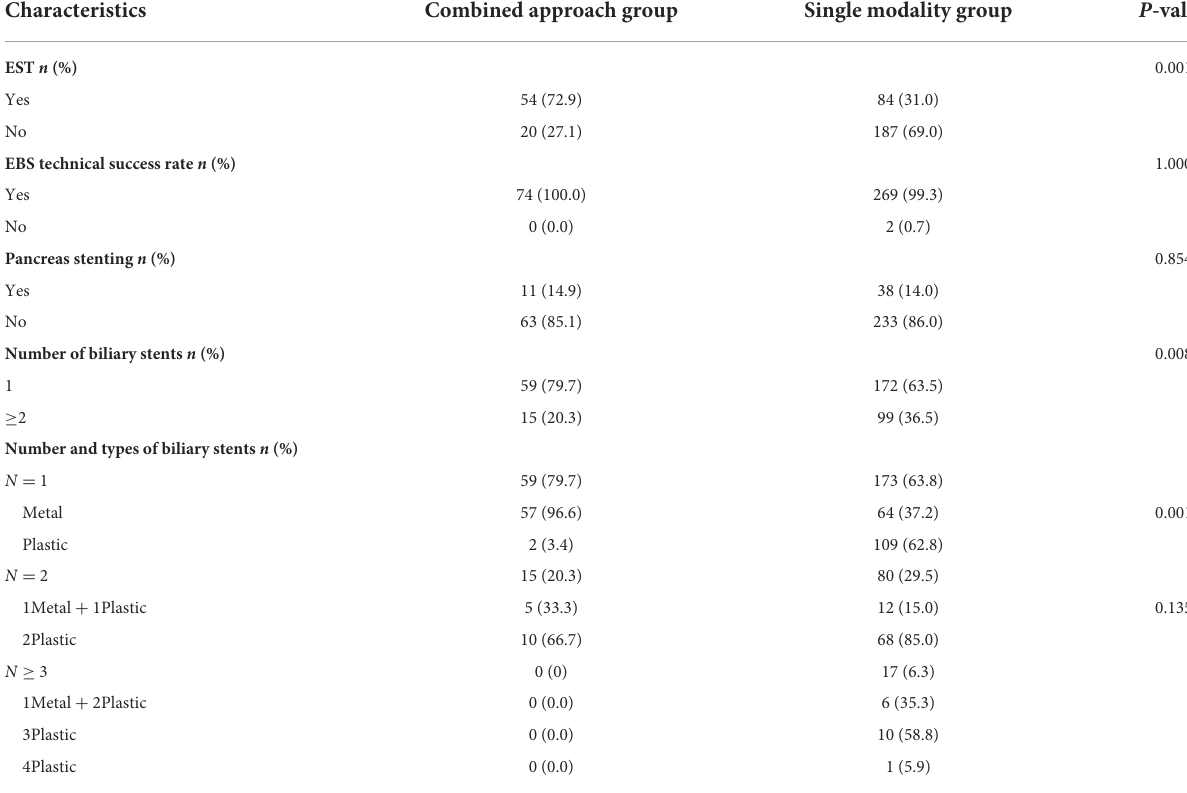
TABLE 3 Comparison of the combined approach group and the single modality group in ERCP procedures. Characteristics Combined approach